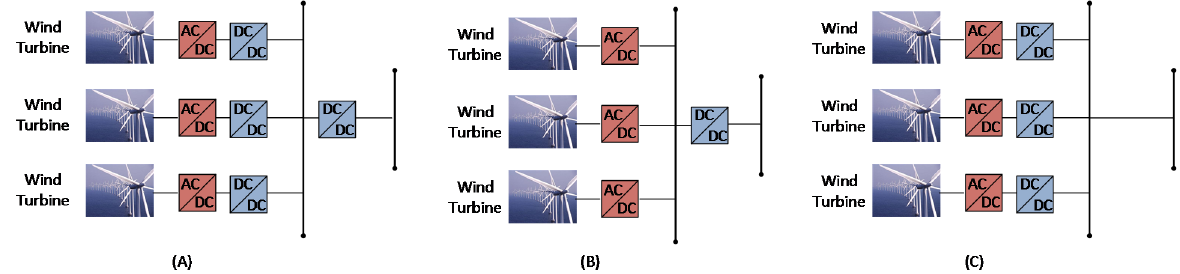
Figure 6. Different configurations for integrating wind turbines (or solar systems) into a DC grid. ( A ) Two step-up conversions. ( B ) Centralized step-up. ( C ) Turbine power